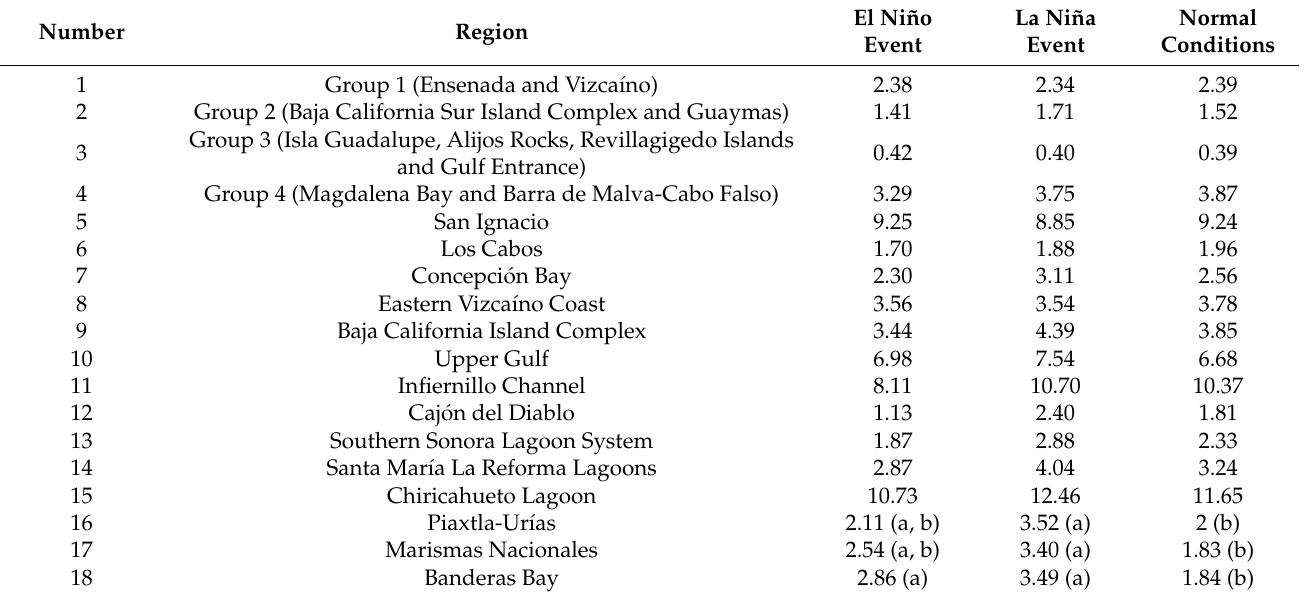
Table 3. Pairwise Permutation Test for the mean monthly summer chlorophyll a (Chl a ) values during El Niño and La Niña events, as well as in normal conditions, in the regions of the Northwest Pacific Ocean, Mexico. Columns sharing the same letter (for a fixed row) are not statistically